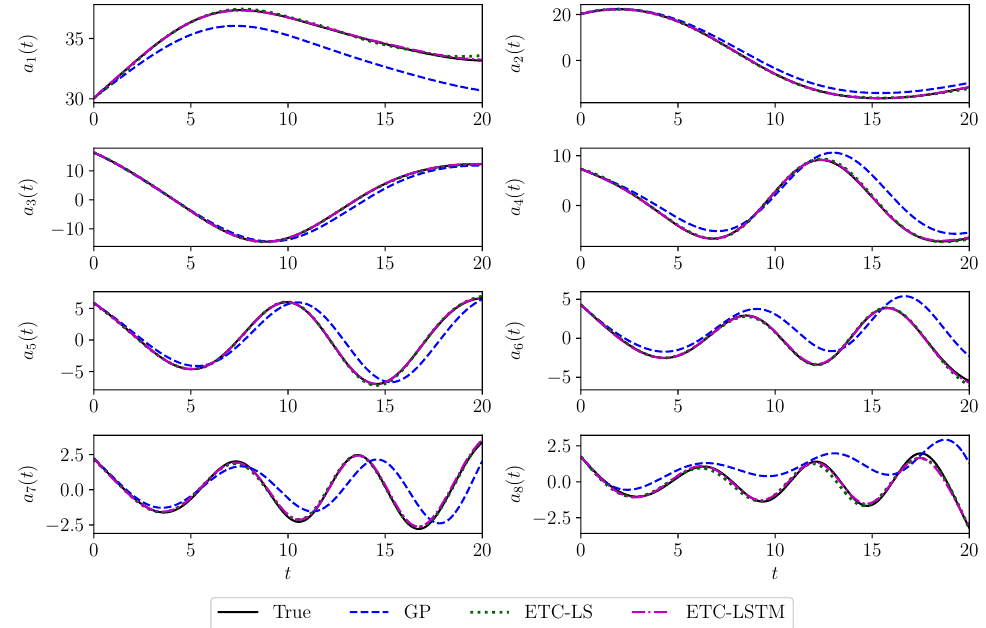
Figure 6. Evolution of vorticity modal coefficients at Re = 1000 for γ = 0.01. GP, Galerkin projection; ETC, evolve-then-correct.